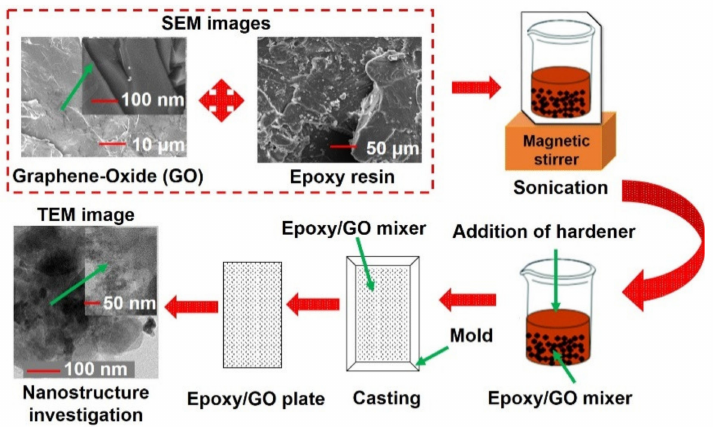
Figure 1. Schematic representation of the fabrication procedure used for epoxy/GO nanocomposites.